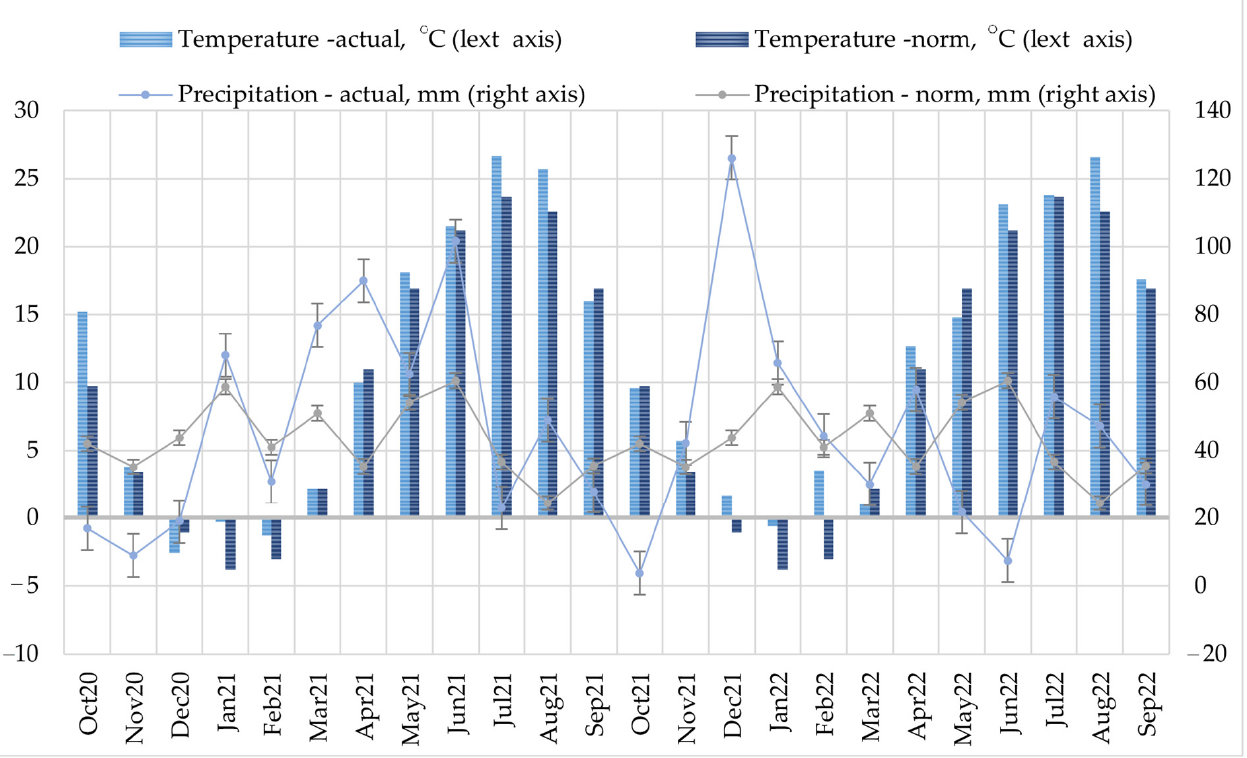
Figure 4. Meteorological parameters: temperature and precipitation during the test period.